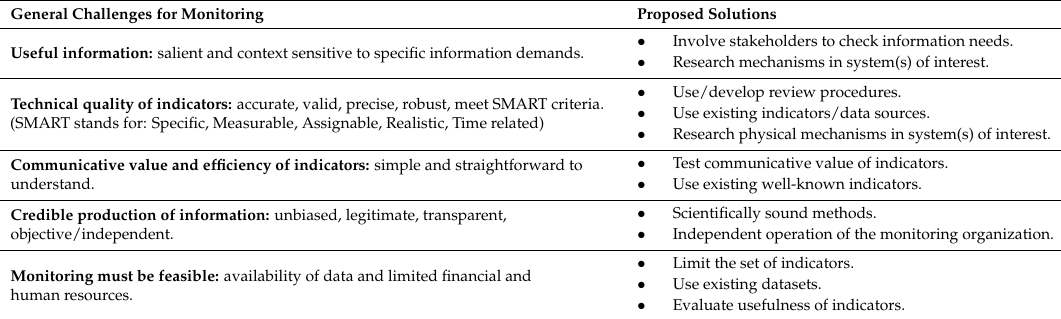
Table 2. General challenges and solutions for monitoring. Adapted from Klostermann et al. (2018). General Challenges for